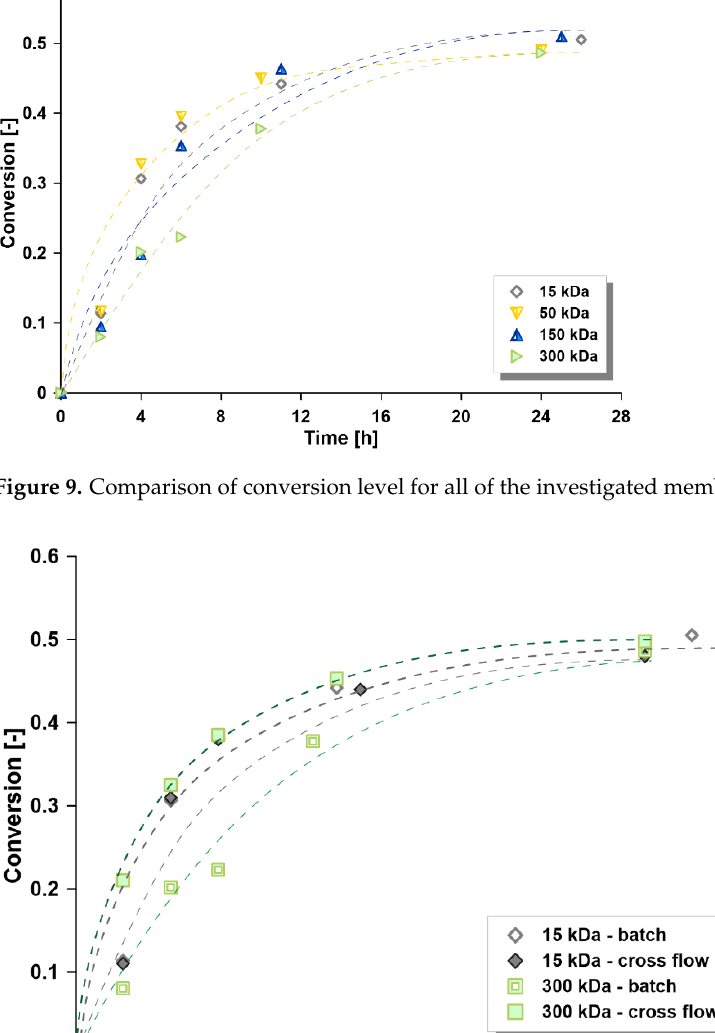
Figure 9. Comparison of conversion level for all of the investigated membranes. Table 3. Results of determination of lipase activity in enzyme membranes depending on membrane cut-off.